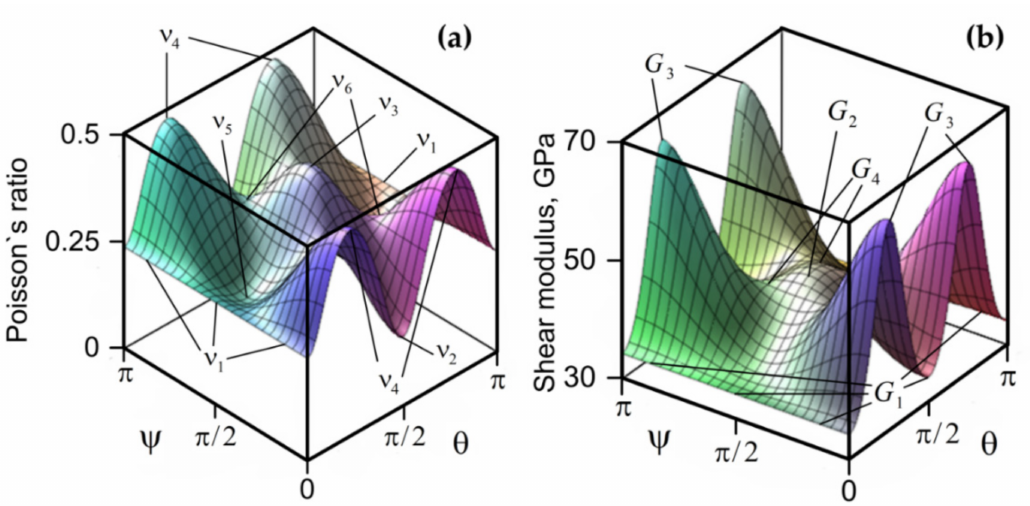
Figure 5. The surfaces of Poisson’s ratio ( a ) and the shear modulus ( b ) for the CeF 3 crystal depending on the two Euler